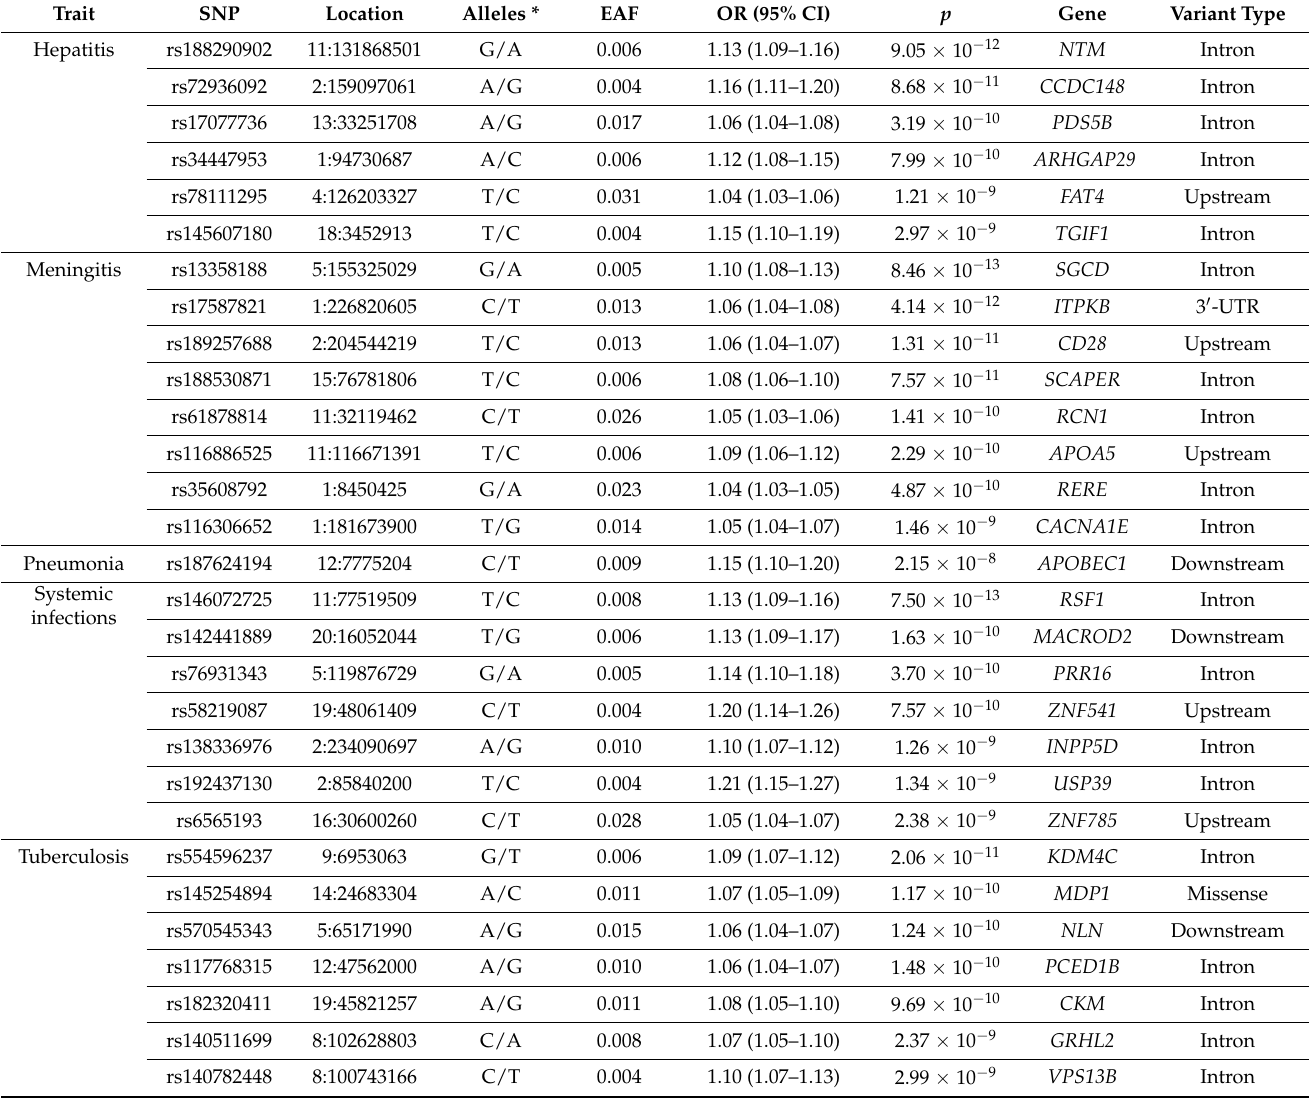
Table 2. Significant results after GWA meta-analyses (filtered for the top leading SNP in ± 500 kb window, Bonferroni corrected associations were significant when p < 3.57 × 10 − 9 or suggestive when p < 5 × 10 − 8 , SNPs were considered not to suffer from heterogeneity based on I 2 statistics when p > 0.05, with same effect direction, variants annotated to protein-coding genes and variants present in meta-analysis for all three sub-cohorts (N =